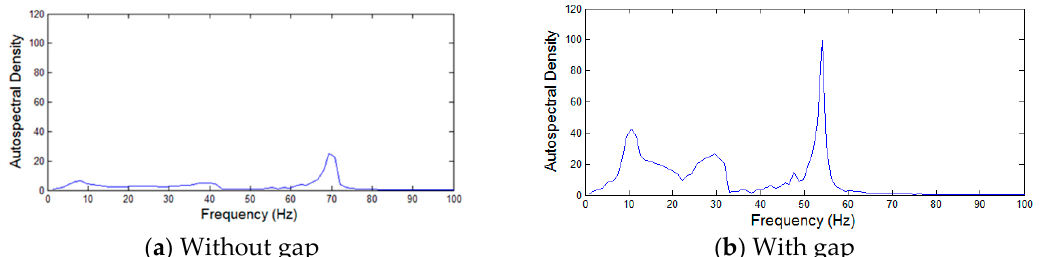
Figure 9. Comparison of autospectral density on the concrete slab surface. ( a ) Without gap. ( b ) With gap.